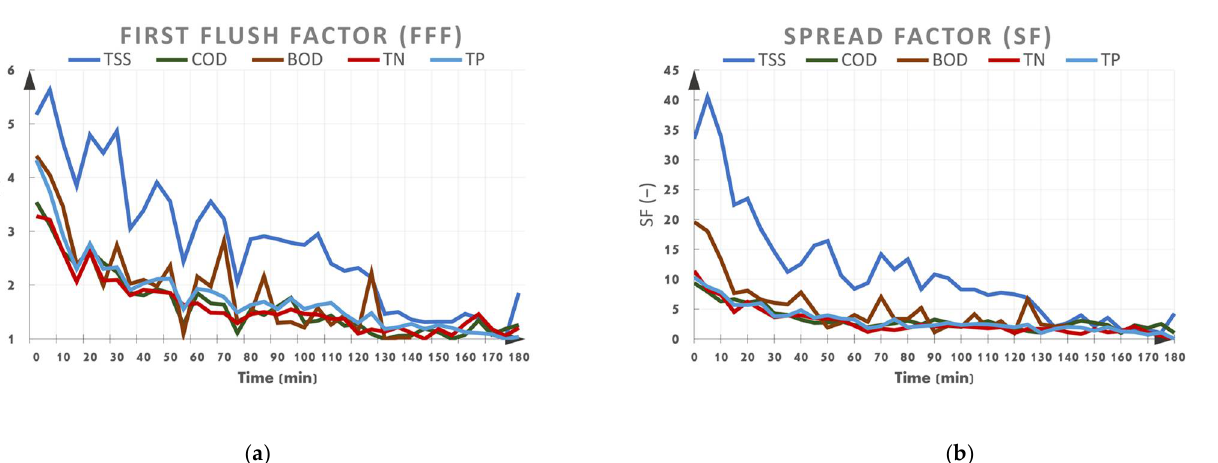
Figure 7. ( a ). First flush factor (FFF) for median (fiftieth percentile) values of 5 pollutants defined as median value vs. minimum median value of time series. ( b ). Spread factor (SF) for midspread (seventy-fifth–twenty-fifth percentile) values of 5 pollutants, defined as midspread value vs. minimum midspread value of time series.